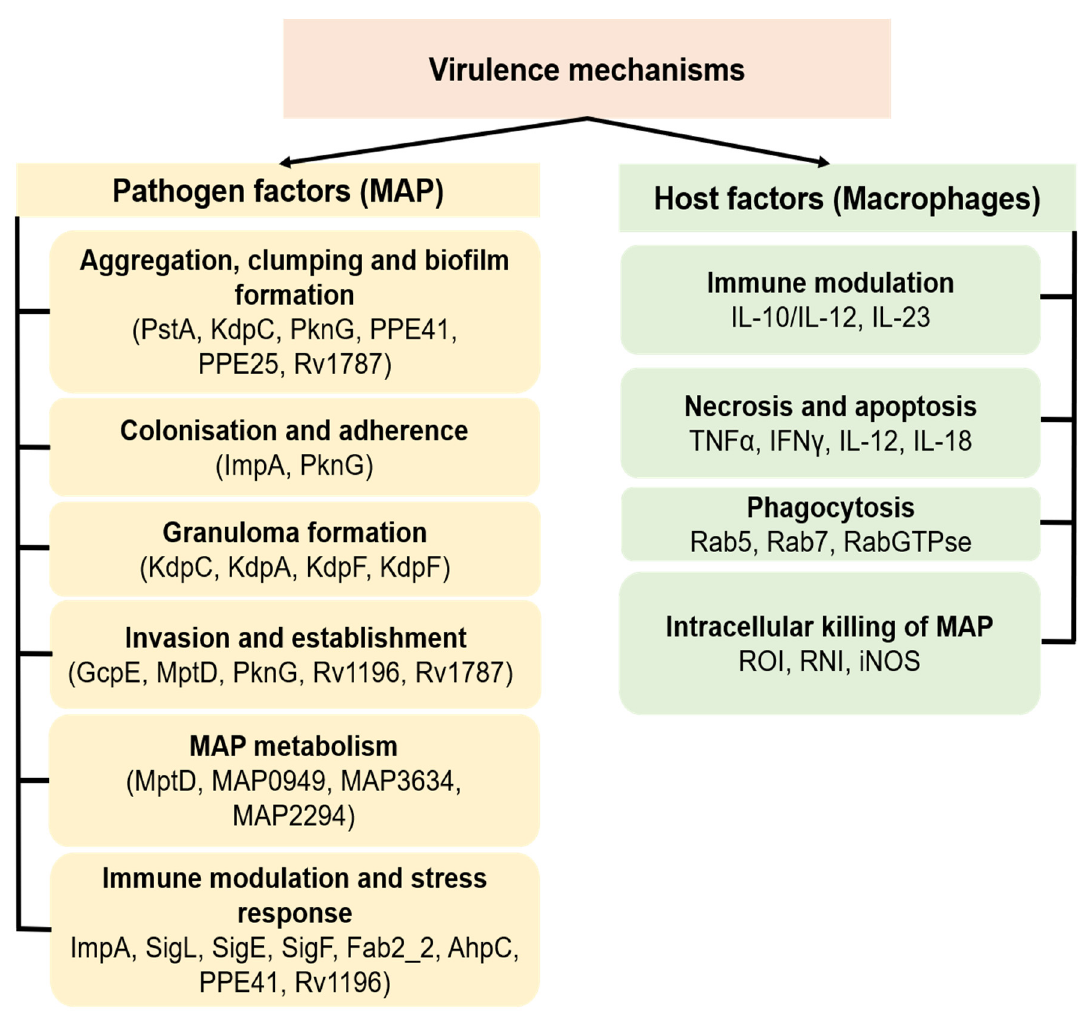
Figure 2. Schematic representation of putative MAP virulence mechanisms and associated host factors. The virulence mechanisms enable MAP to gain entry, survive, multiply and cause disease in the host by interacting and sometimes disabling the host defense mechanism and metabolism. Because limited information is available concerning the expression and actions of virulence factors in MAP, most of the current understanding of MAP virulence is imputed from the functions of such factors in related mycobacteria.